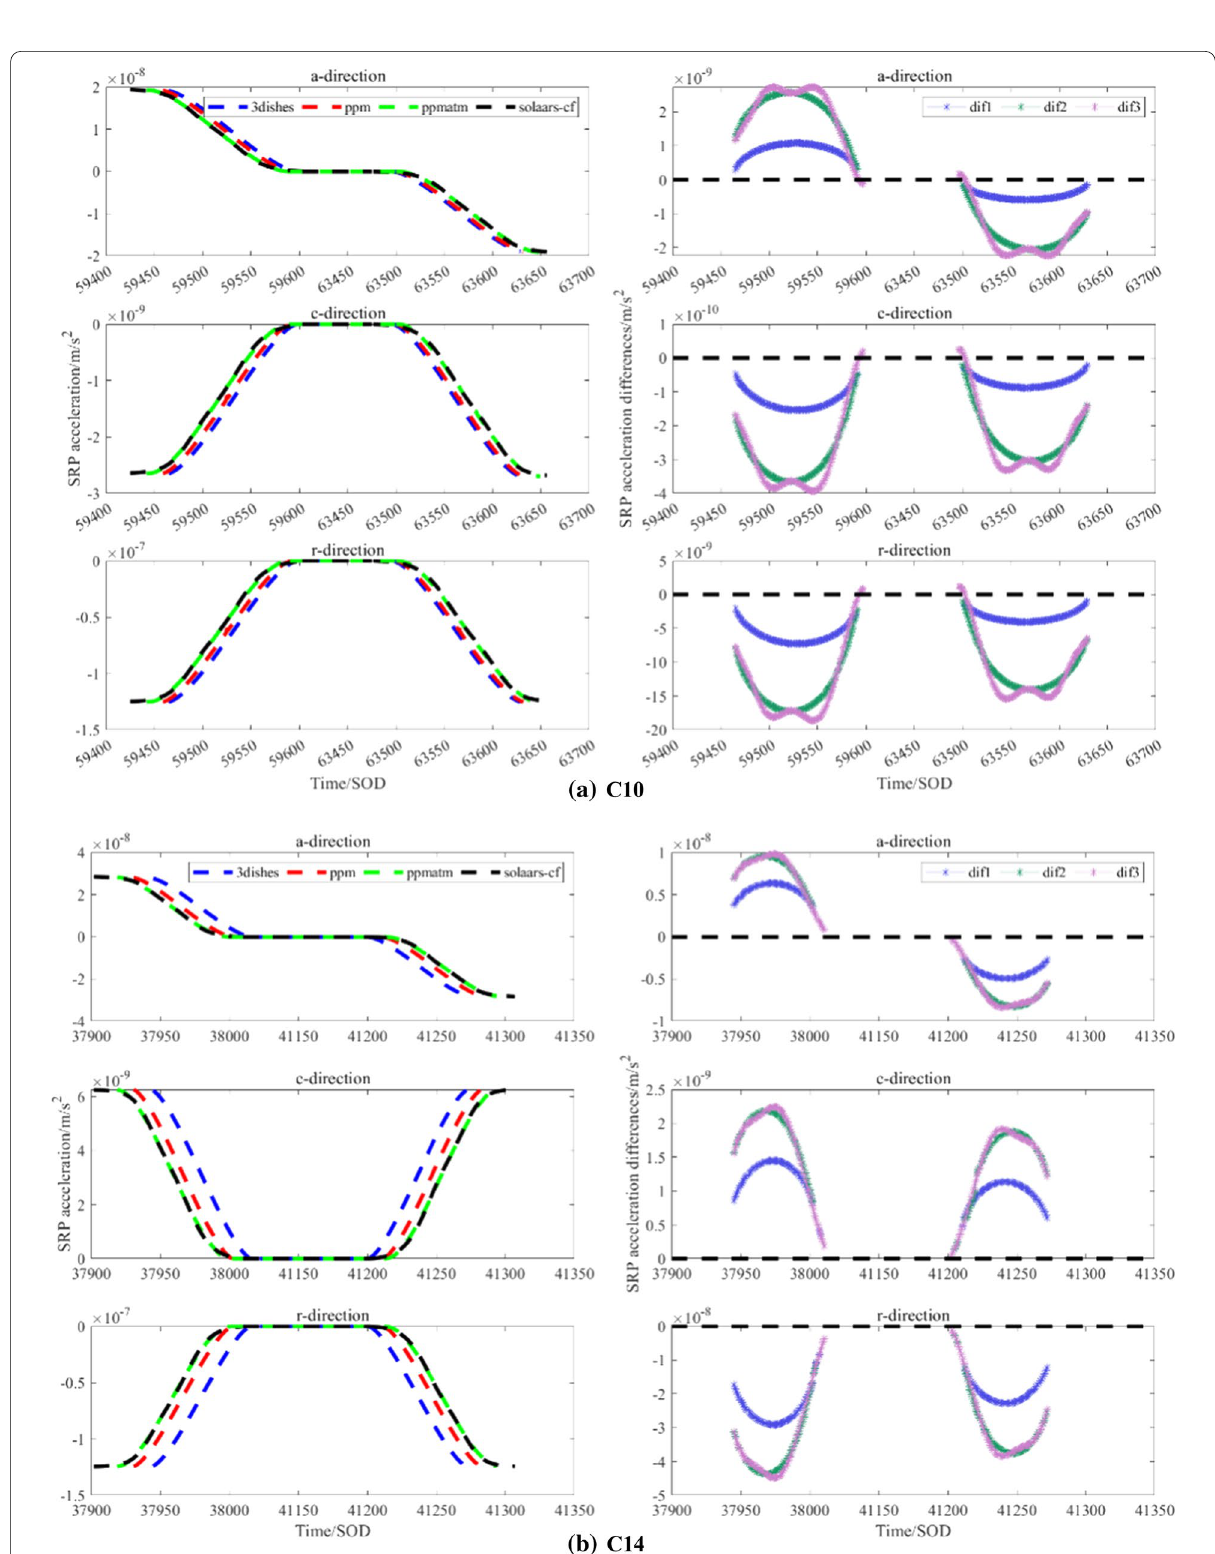
Fig. 7 a SRP acceleration variation of C10 (IGSO) in eclipse in 2019/007. b SRP acceleration variation of C14 (MEO) in eclipse in 2019/060. c SRP acceleration variation of C01 (GEO) in eclipse in 2019/069. Each figure is composed of SRP acceleration (left) and their differences (right) between other three models with regard to 3dishes. In each side of figure, including along trace direction (top), cross trace direction (middle) and radial trace direction